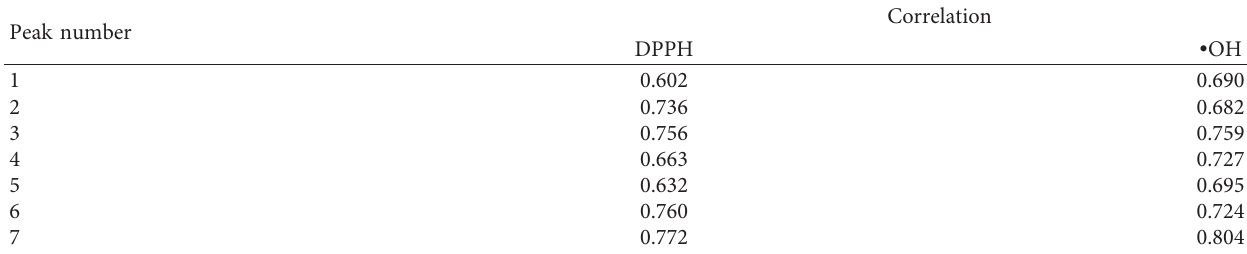
Figure 7: DPPH and ∙ OH scavenging activity of 21 batches of saffron of different concentration (a, b) and IC 21 batches of saffron Table 5: Results of correlation of HPLC fingerprint with antioxidant activities of saffron.